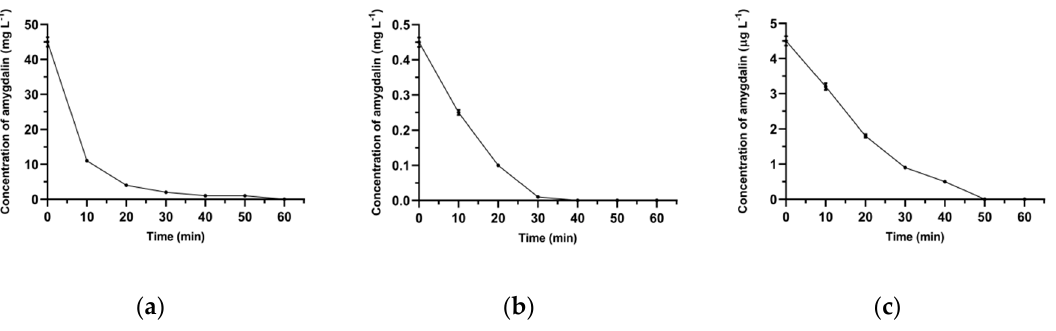
Figure 16. X-ray fluorescence (XRF) spectrum of Fe 3 O 4 @SiO 2 @VIN@MIP.